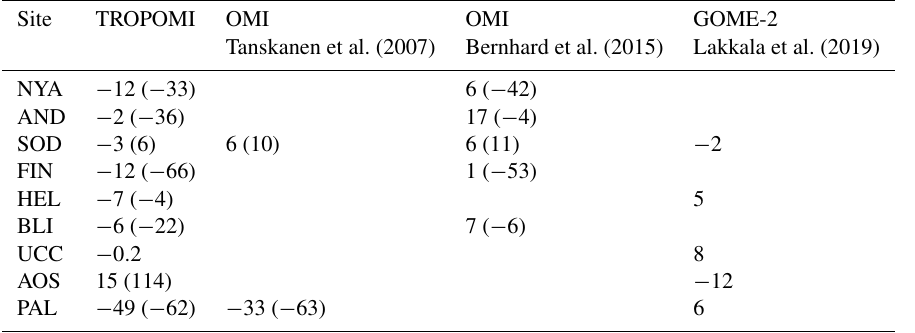
Table 7. OMI (satellite/ground-1) and GOME-2 erythemally weighted daily dose validation results together with TROPOMI validation results. The median of the relative difference (%) is shown. The values in parenthesis are for snow cover conditions. In GOME-2 results for snow-free and snow cover conditions are not calculated separately.